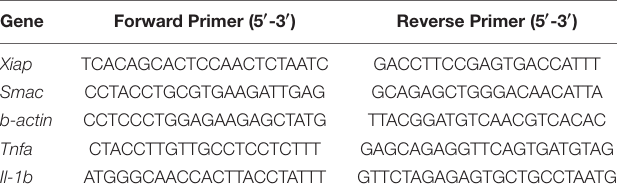
TABLE 1 | Mouse primers used in RT-qPCR